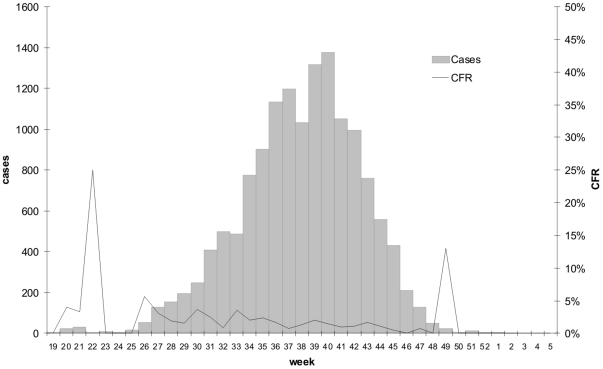
Weekly number of cholera cases and case fatality ratio (CFR%) in Guinea-Bissau 2008–2009.